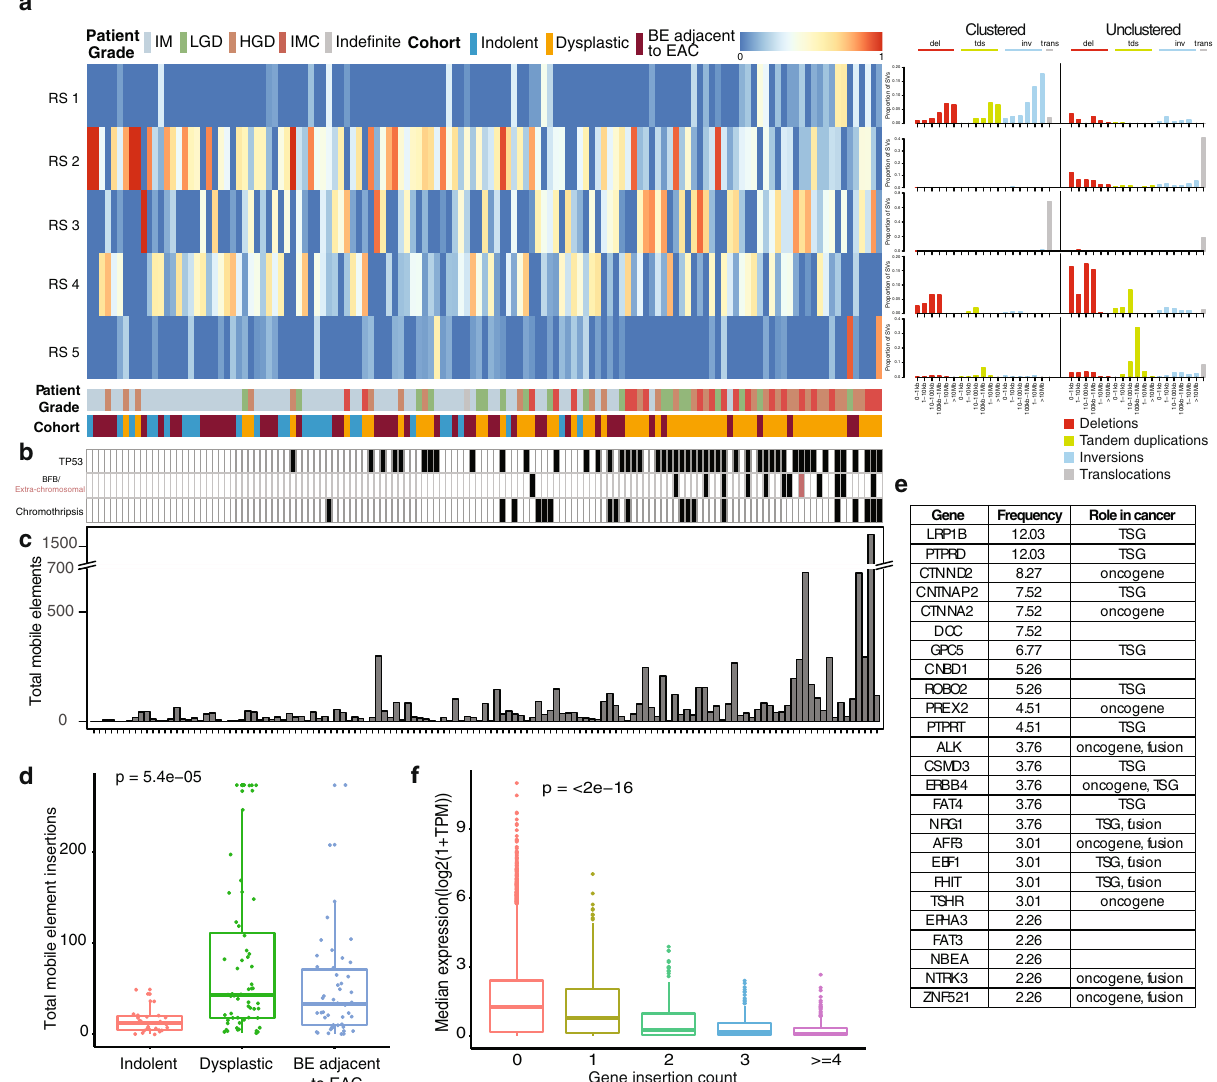
Fig. 6 Complex structural variant analysis: mobile element insertions. a Structural rearrangement signature (RS) proportions in the cohort: RS1 is dominated by clustered rearrangements; RS2 by unclustered translocations and deletions; RS3 by clustered translocations; RS4 is dominated by deletions; RS5 by tandem duplications >100 kb. Samples remain ordered by the total number of SV events with patient grade and cohort given. b TP53 mutation, breakage-fusion-bridge cycles (BFB) and chromothripsis events in the cohort. c The total number of mobile elements in each sample along the continuum. d Distribution of total mobile element insertion across different grades of samples. Indolent ( n = 27), Dysplastic ( n = 60), BE adjacent to EAC ( n = 46). Boxplot centre line denotes median, box limits are upper and lower quartiles, whiskers denote 1.5* the interquartile range. Kruskal – Wallis test was used to compare groups. e Twenty-eight genes with oncogenic and tumour suppressor roles affected by recurrent (>3) mobile element insertions (as annotated by the Cancer Gene Consensus). f All genes are grouped by number of mobile element insertions and then their expression plotted. 0 ( n = 17564), 1 ( n = 1156), 2 ( n = 277), 3 ( n = 139), ≥ 4 ( n = 190). Boxplot centre line denotes median, box limits are upper and lower quartiles, whiskers denote 1.5* the interquartile range. Kruskal – Wallis test was used to compare